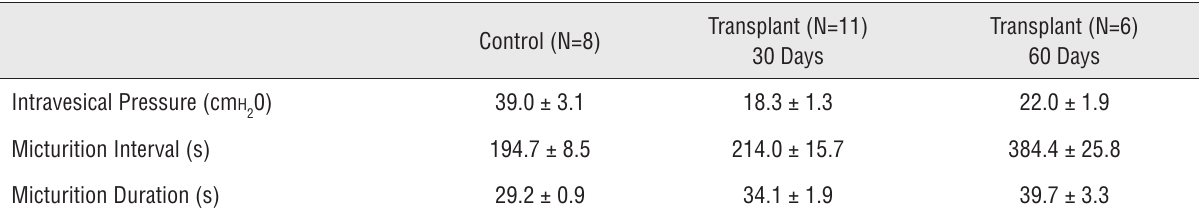
Table 2 - Cystometric values in female spontaneous hypertension rats (ShR) that underwent urinary bladder syngeneic transplant .